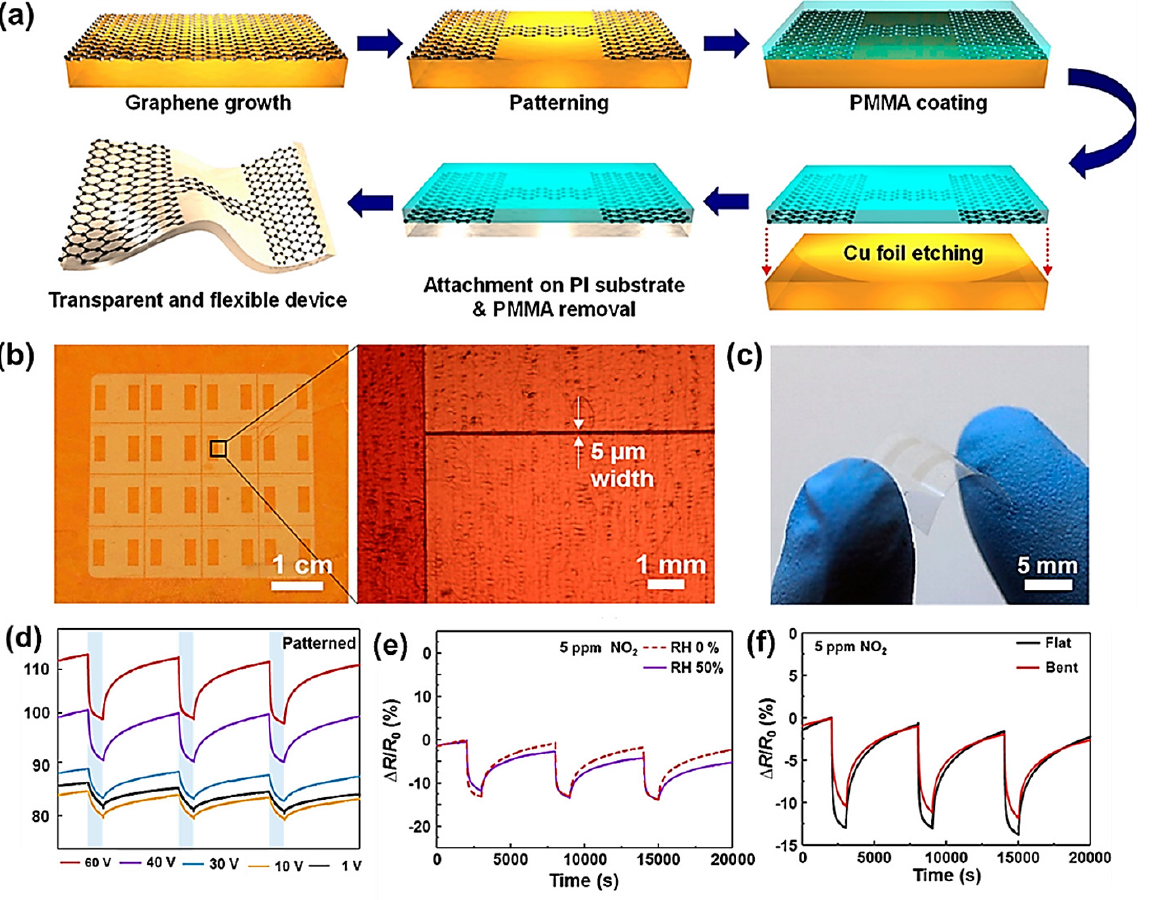
Figure 17. ( a ) Production process of PG sensor, ( b ) optical micrographs of patterned graphene on top of copper foil, ( c ) photo of a fabricated PG gas sensor on a PI substrate, ( d ) response curves under different bias voltages, ( e ) output under relative humidity conditions of 0% and 50% at 60V, and ( f ) response without and with the bending strains. Adopted with permission from [140].